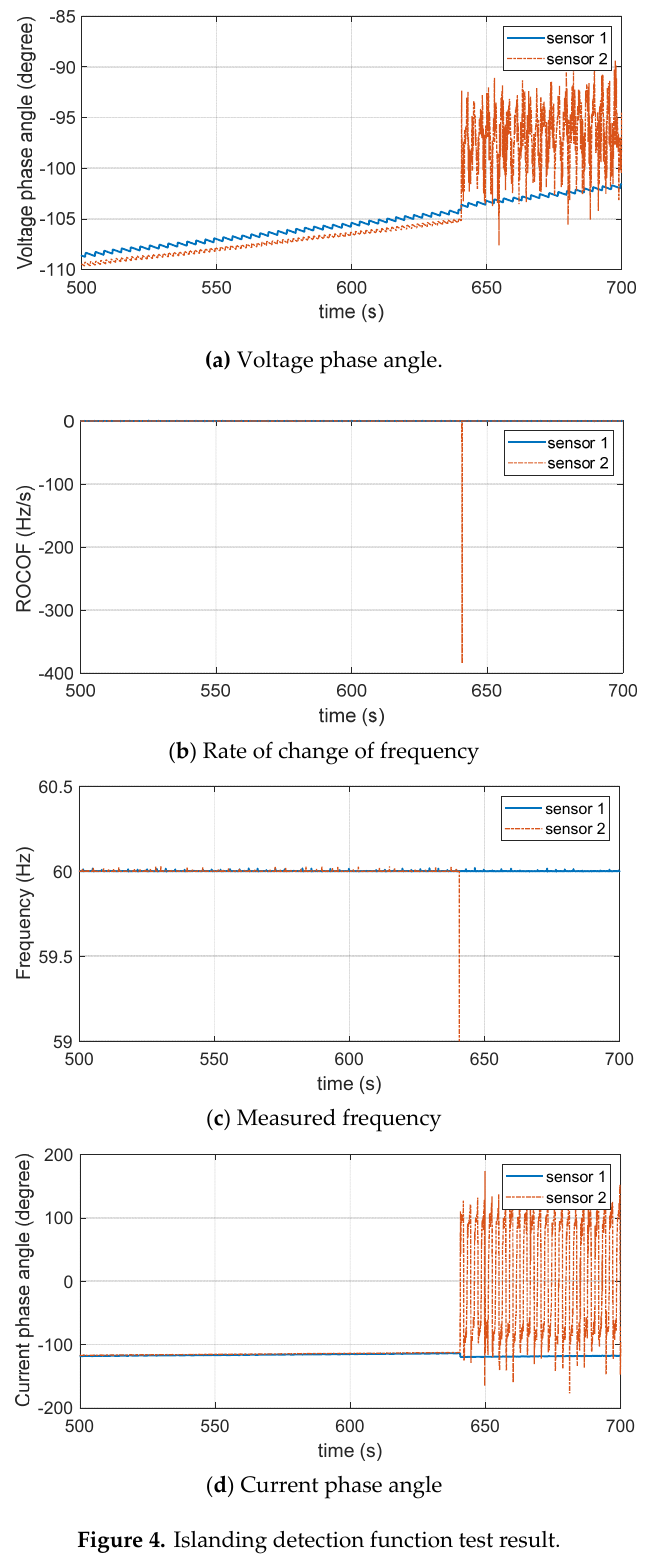
Figure 4. Islanding detection function test result.